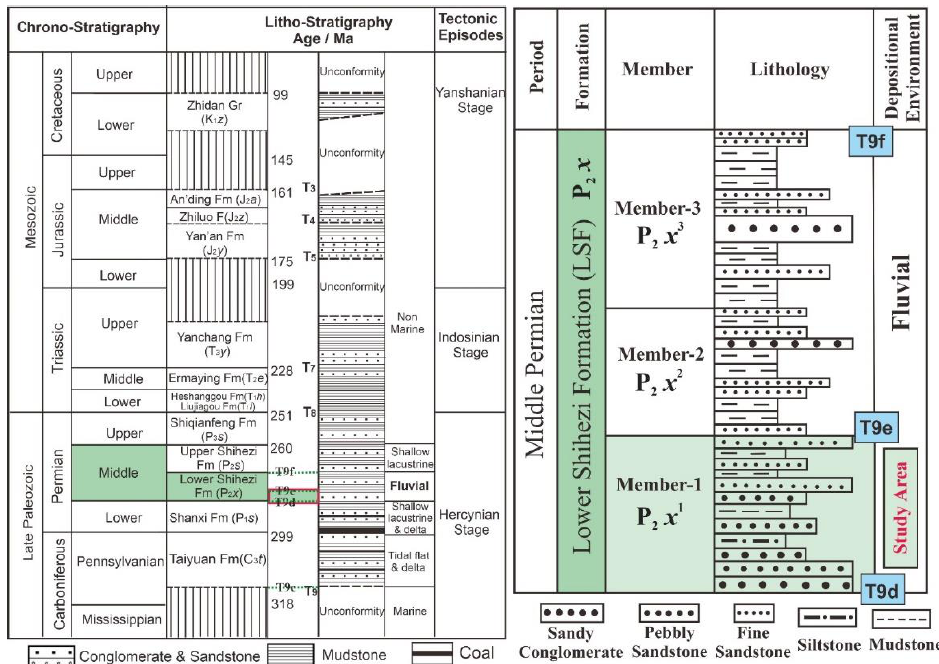
Figure 2. Generalized stratigraphic chart of the Hangjinqi area, OB ( left ). Three members of the lower Shihezi formation ( right ). The light green rectangles highlight the targeted formation and member, while the red-colored text shows the study area (Modified from [30]).